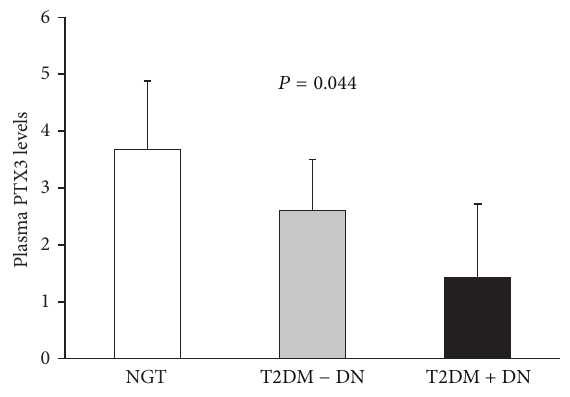
Figure3:PlasmaPTX3levelsinoverweightMalaymenwithnormal glucose tolerance and type 2 diabetes patients with or without diabetic nephropathy. Data presented as means with 95% CI; 𝑃 values were from ANOVA tests; NGT: normal glucose tolerance; T2DM: type 2 diabetes; DN: diabetic